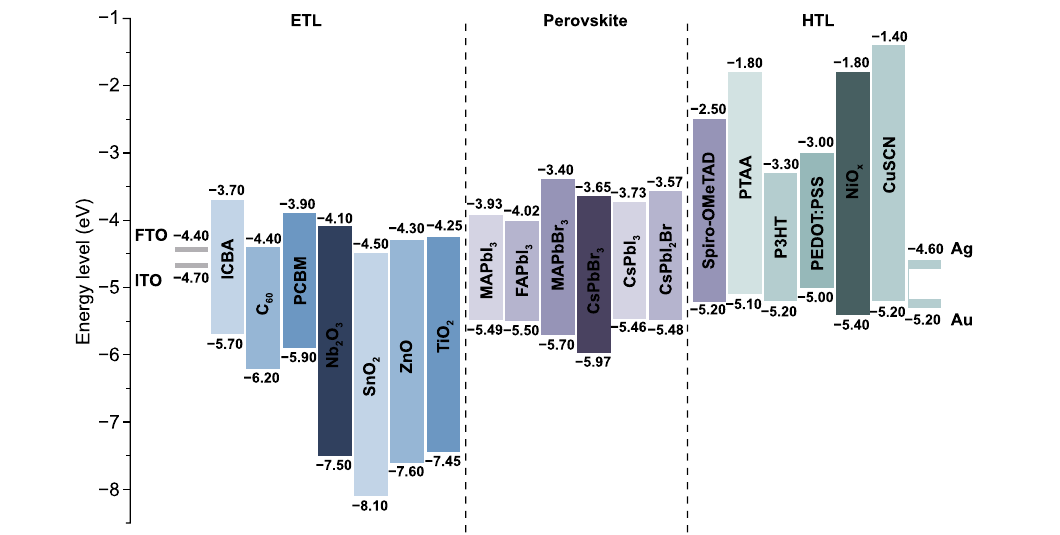
Fig. 10 Energy level diagram of perovskites, ETLs, HTLs and electrodes in